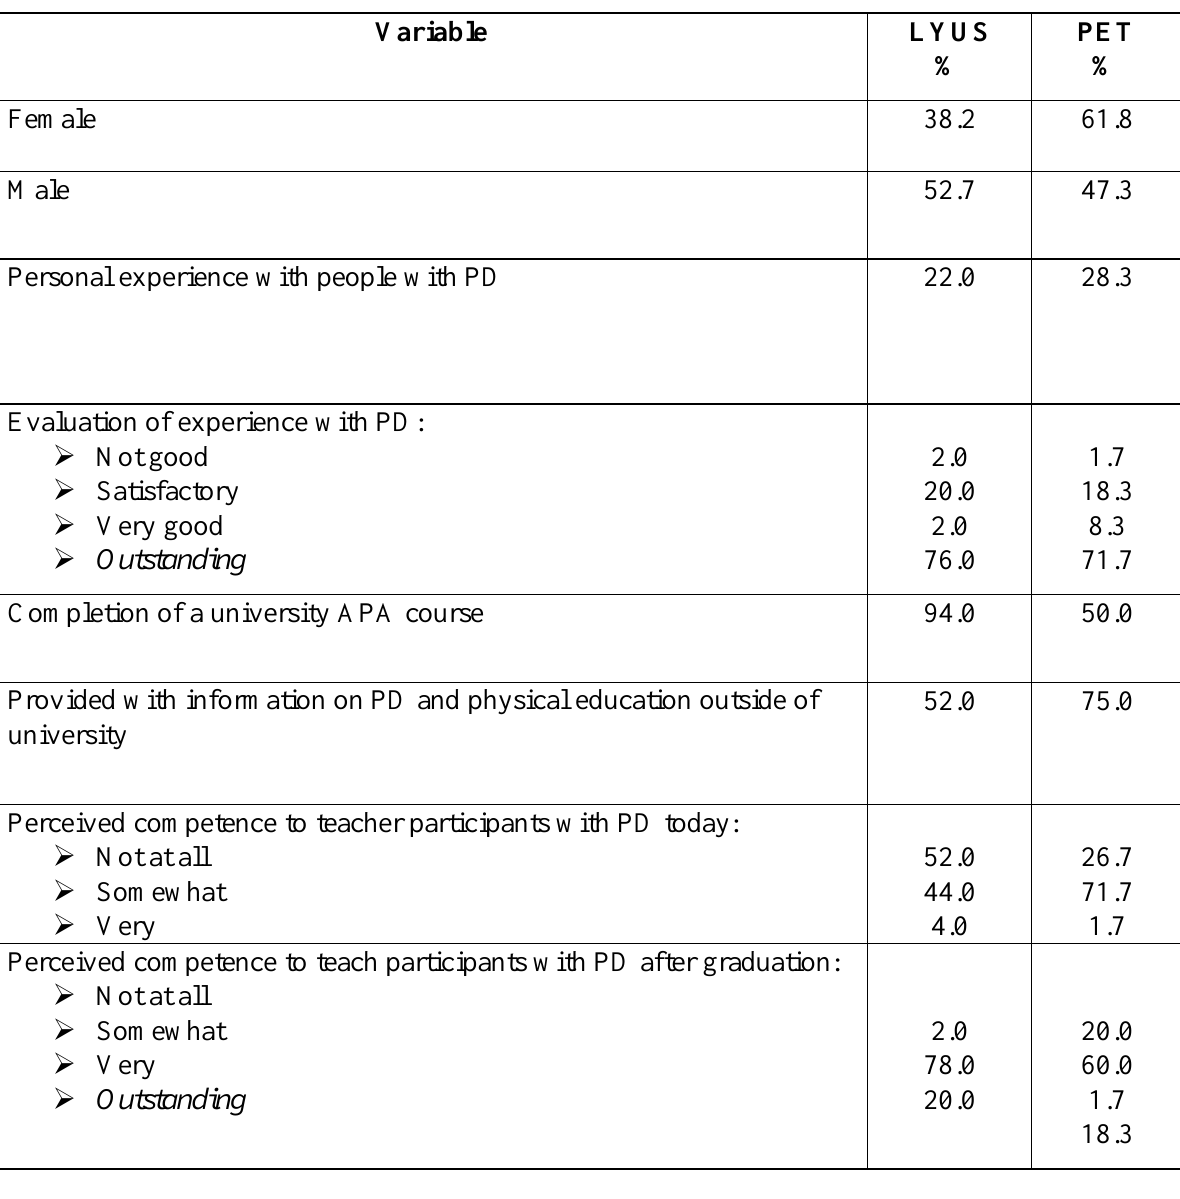
Table 3 Demographic Data - LYUS and